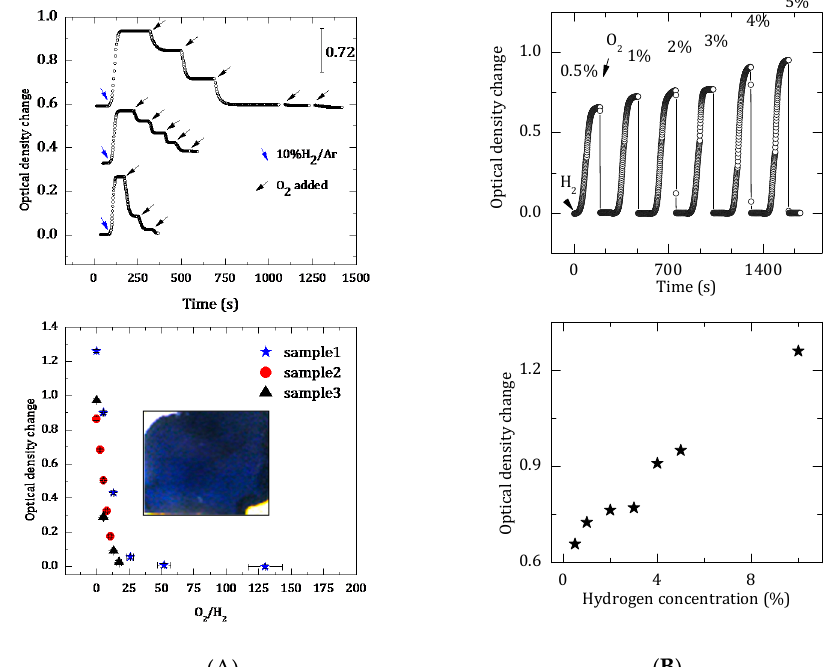
Figure 2. ( A ) Top: time variation of optical density change for oxyhydrogen gas for different samples of low, medium and high Pd content. Bottom: optical density change versus O 2 /H 2 ratio and a photographic image of colored sample; ( B ) Top: time variation curves of optical density change bottom the optical density as a function of hydrogen